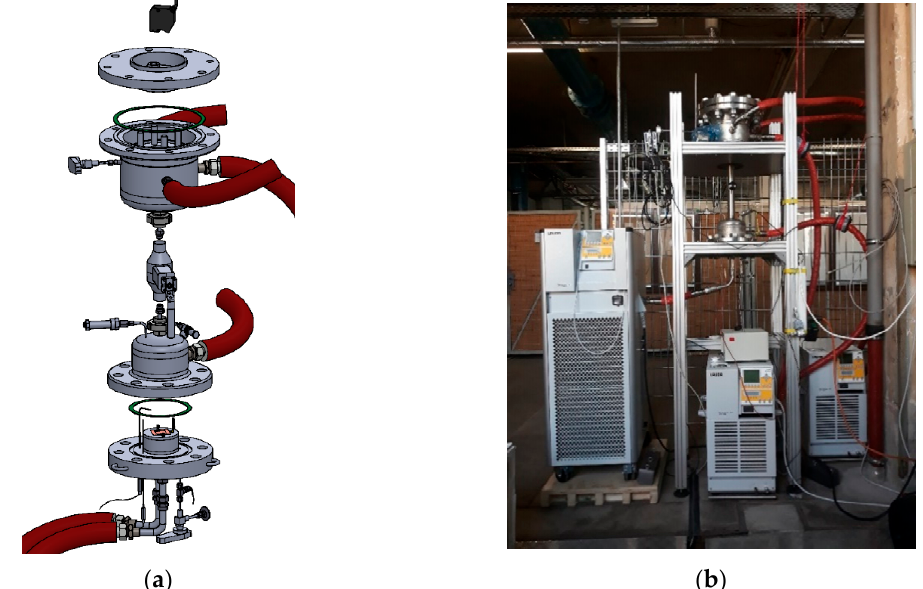
Figure 3. Explosion view ( a ) and photograph ( b ) of the macrokinetic installation.